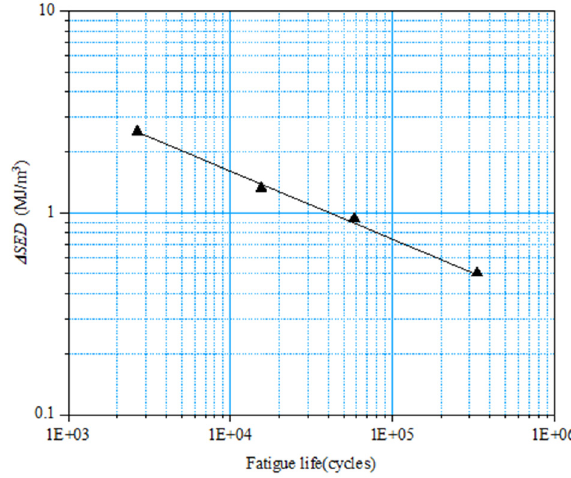
Figure 6. Δ SED–N f curve of apex. Figure 6. ∆ SED–N f curve of apex.